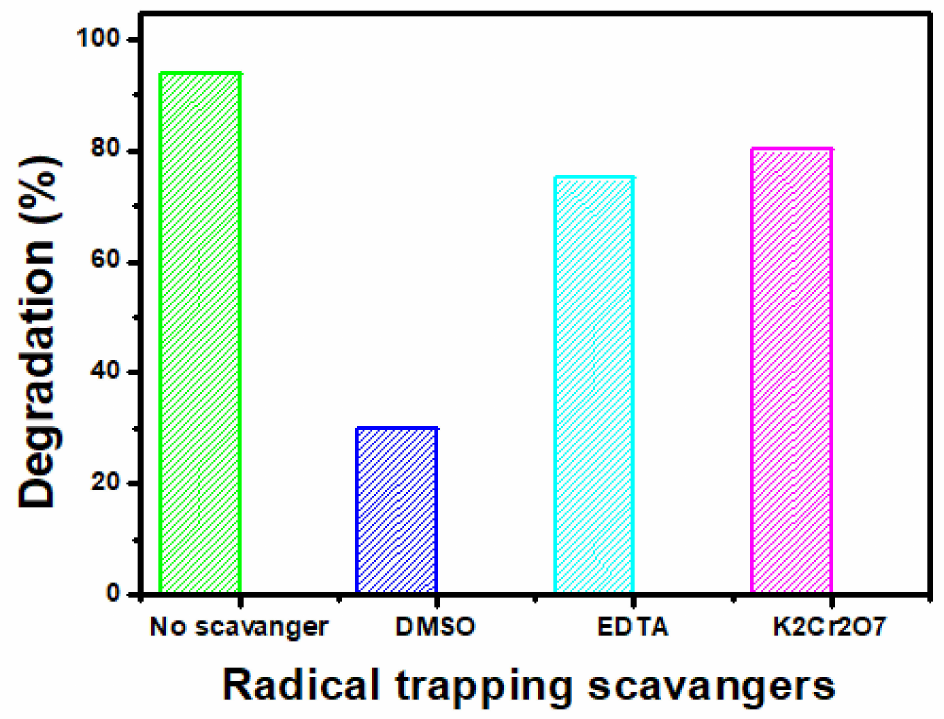
Figure 9. Estimation of effective radicals using key radical scavenger for TNG-08 under optimized reaction